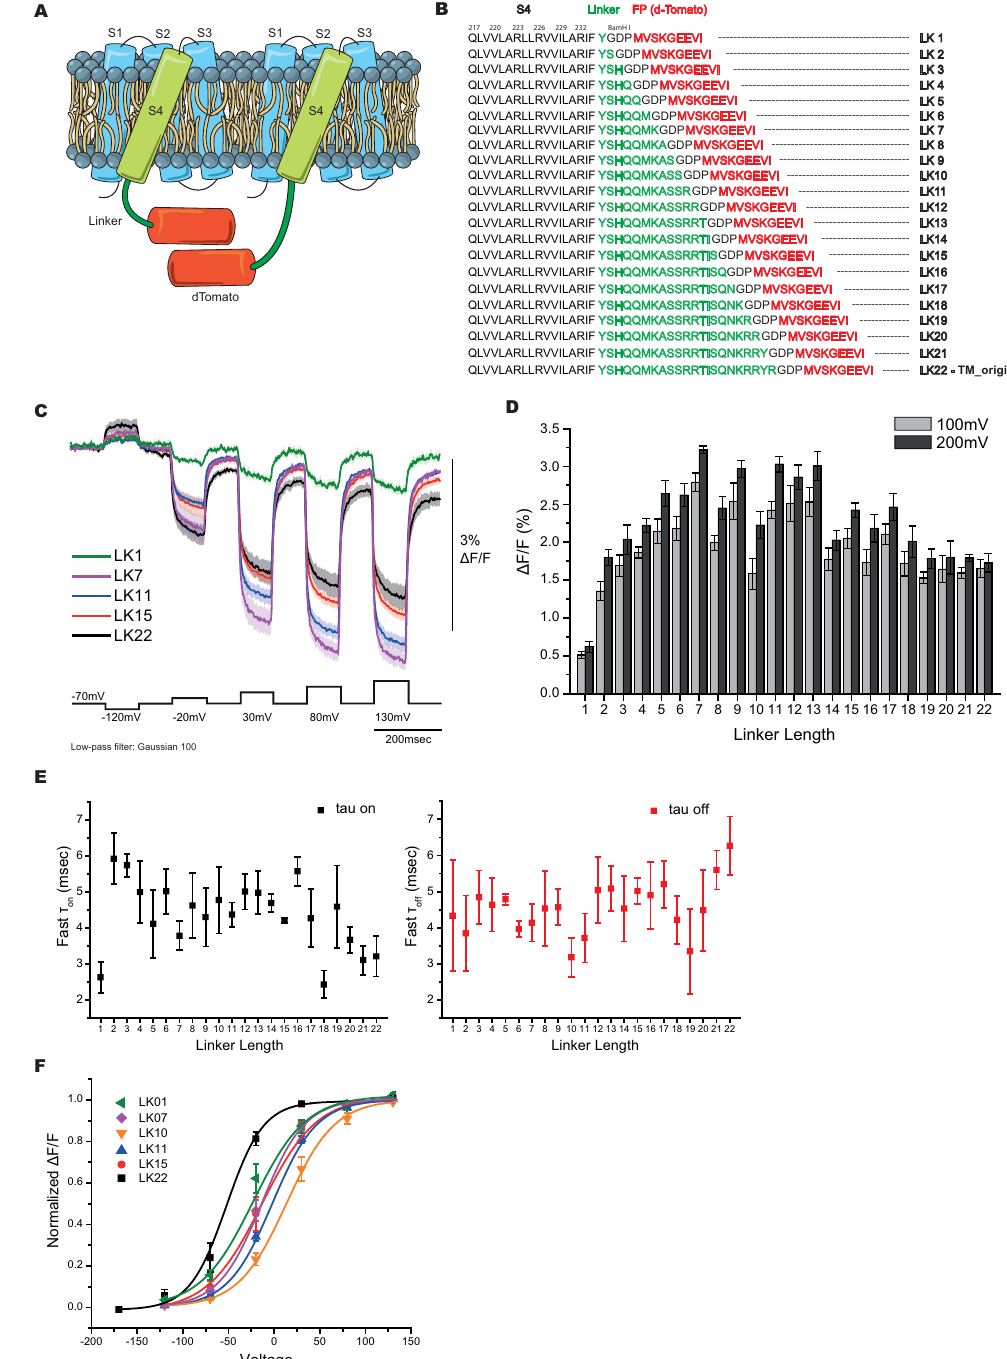
Figure 1. Red-shifted GEVIs with altered linker lengths. ( A ) Schematic presentation of a GEVI with a single dTomato chromophore. The VSD (S1-S4) resides in the plasma membrane with dTomato fused to the carboxy- terminus via a linker segment. ( B ) The amino acid sequence of the varying linker lengths (LK1-LK22) to optimize voltage-dependent signal. The linker segment is in green. dTomato sequence is in red. The GDP sequence between the linker and dTomato is due to a BamHI cloning site. ( C ) Optical traces in response to membrane depolarizations. The average of at least four HEK cells expressing LK1 (green), LK7 (purple), LK11 (blue), LK15 (red), and LK22 (black). The color-coordinated shaded areas are standard errors of the mean. The command voltage pulses are shown below in black. An offline, low-pass Gaussian filter was used for all cells. ( D ) Comparison of the average signal size at 100 mV (grey bars) and 200 mV (black bars) depolarizations of the plasma membrane of all linker lengths tested. ( E ) The fast τ on (black) and fast τ off (red) for each linker tested. ( F ) Boltzmann fit of the normalized fluorescence change in response to membrane potential (n ≥ 4 for all